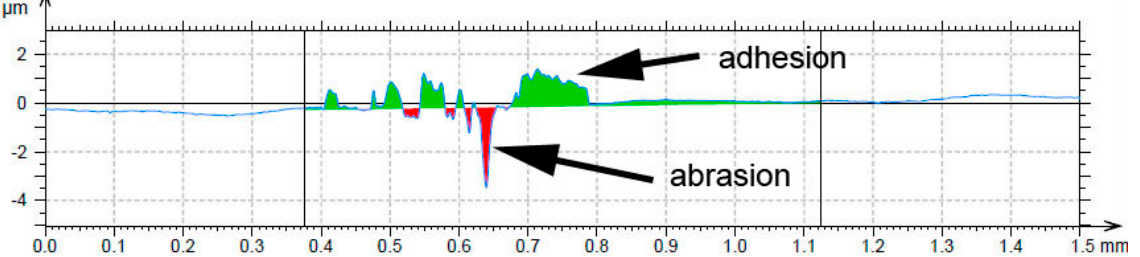
Figure 10. Wear track profile on the alloy reduced with stoichiometric amount of aluminum after testing by steel 100Cr6 ball.